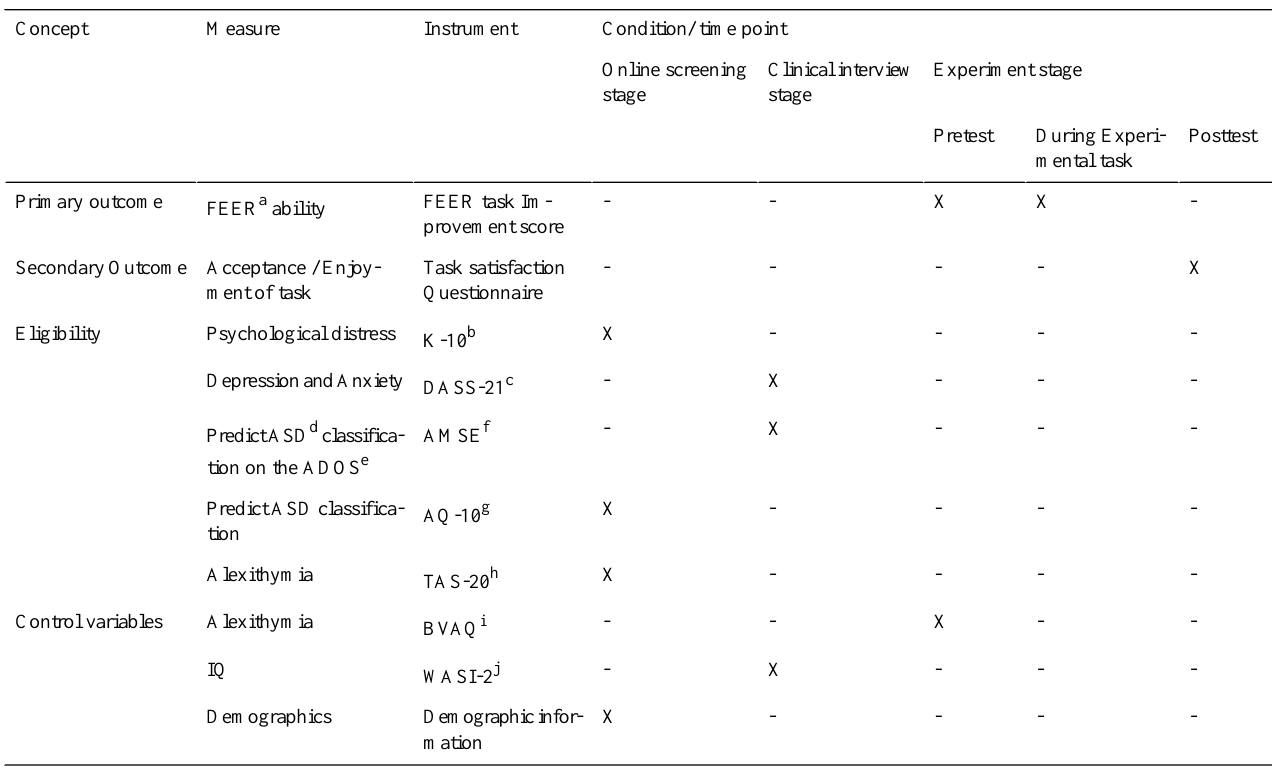
Table 1. Study design and